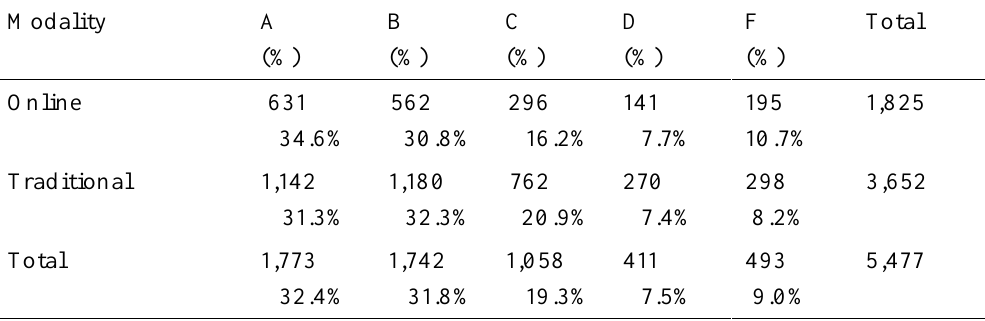
Contingency Table for Students’ Academic Performance (N =